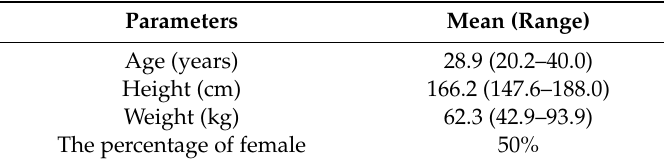
Table 3. The demographic characteristics of the participated subjects for virtual Korean population ( n =